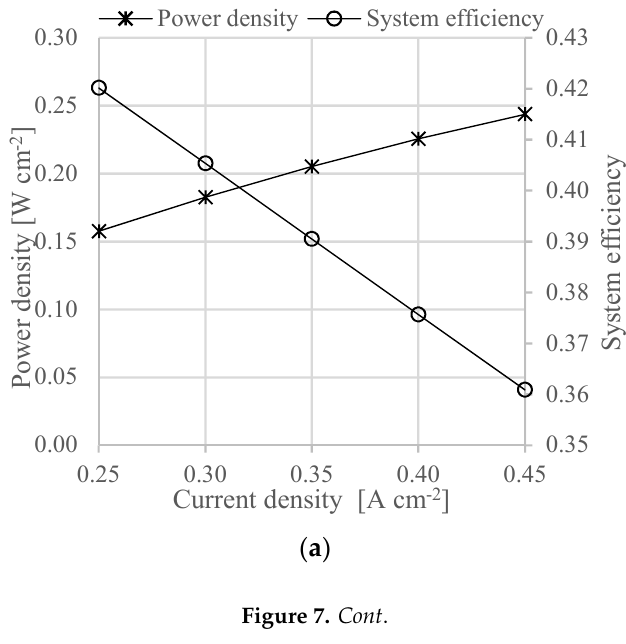
· a typical tradeo ff for fuel cell systems between power density and e ffi ciency. Both a ff ect the energy consumption of ancillaries.